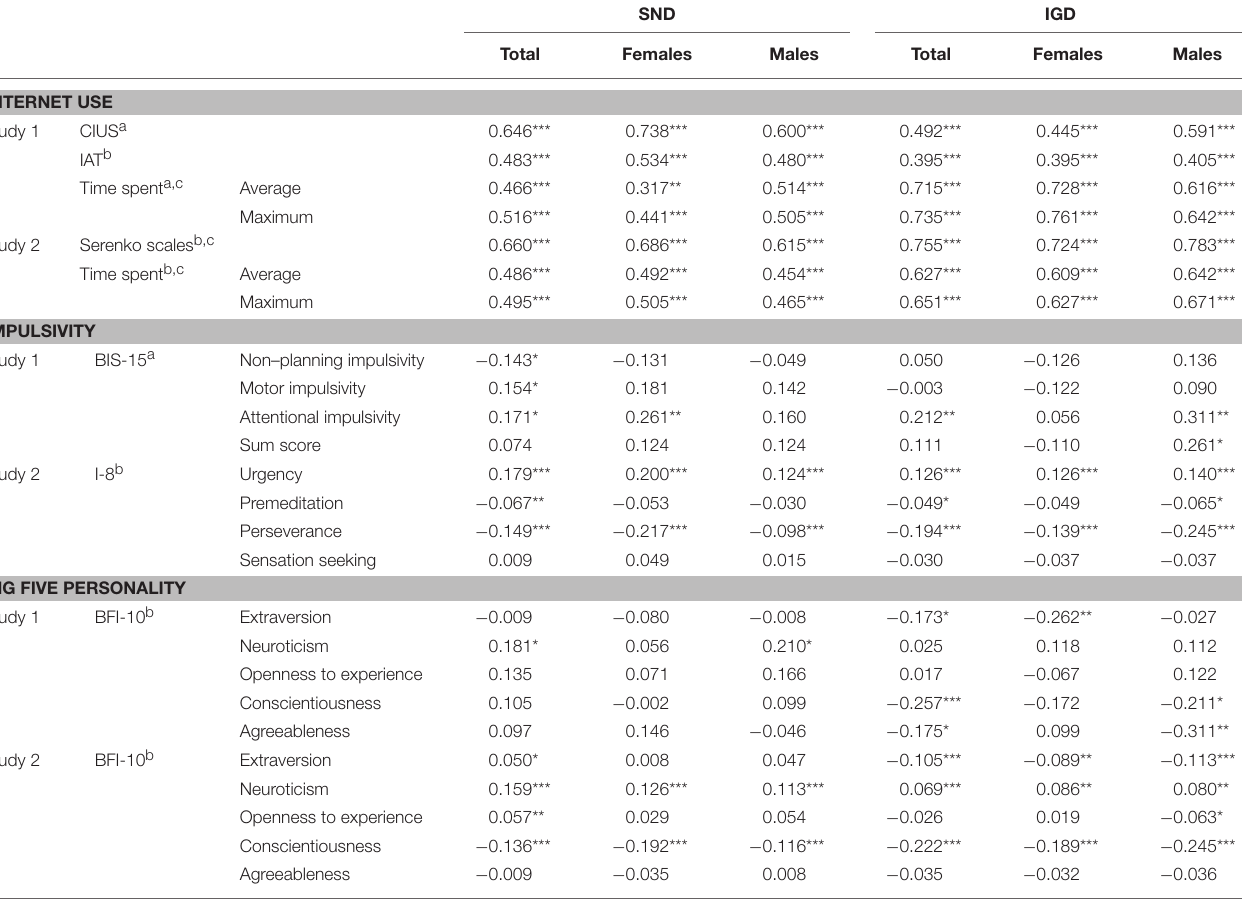
The table shows Spearman correlations ( ρ ) between the number of affirmed SND and IGD criteria (assessed on-site for Study 1 and online for Study 2) and internet use, impulsivity, and personality. SND, social network use disorder; IGD, internet gaming disorder; CIUS, Compulsive Internet Use Scale; IAT, Internet Addiction Test; BIS − 15, Barrat Impulsiveness Scale – short version; I − 8, Scale Impulsive Behavior − 8; BFI − 10, Big–Five–Inventory − 10. a On–site assessment, b online assessment. c Time spent on social networking sites and Serenko scales adapted to social network use were correlated with SND criteria, and time spent on internet gaming and Serenko scales adapted to internet gaming were correlated with IGD